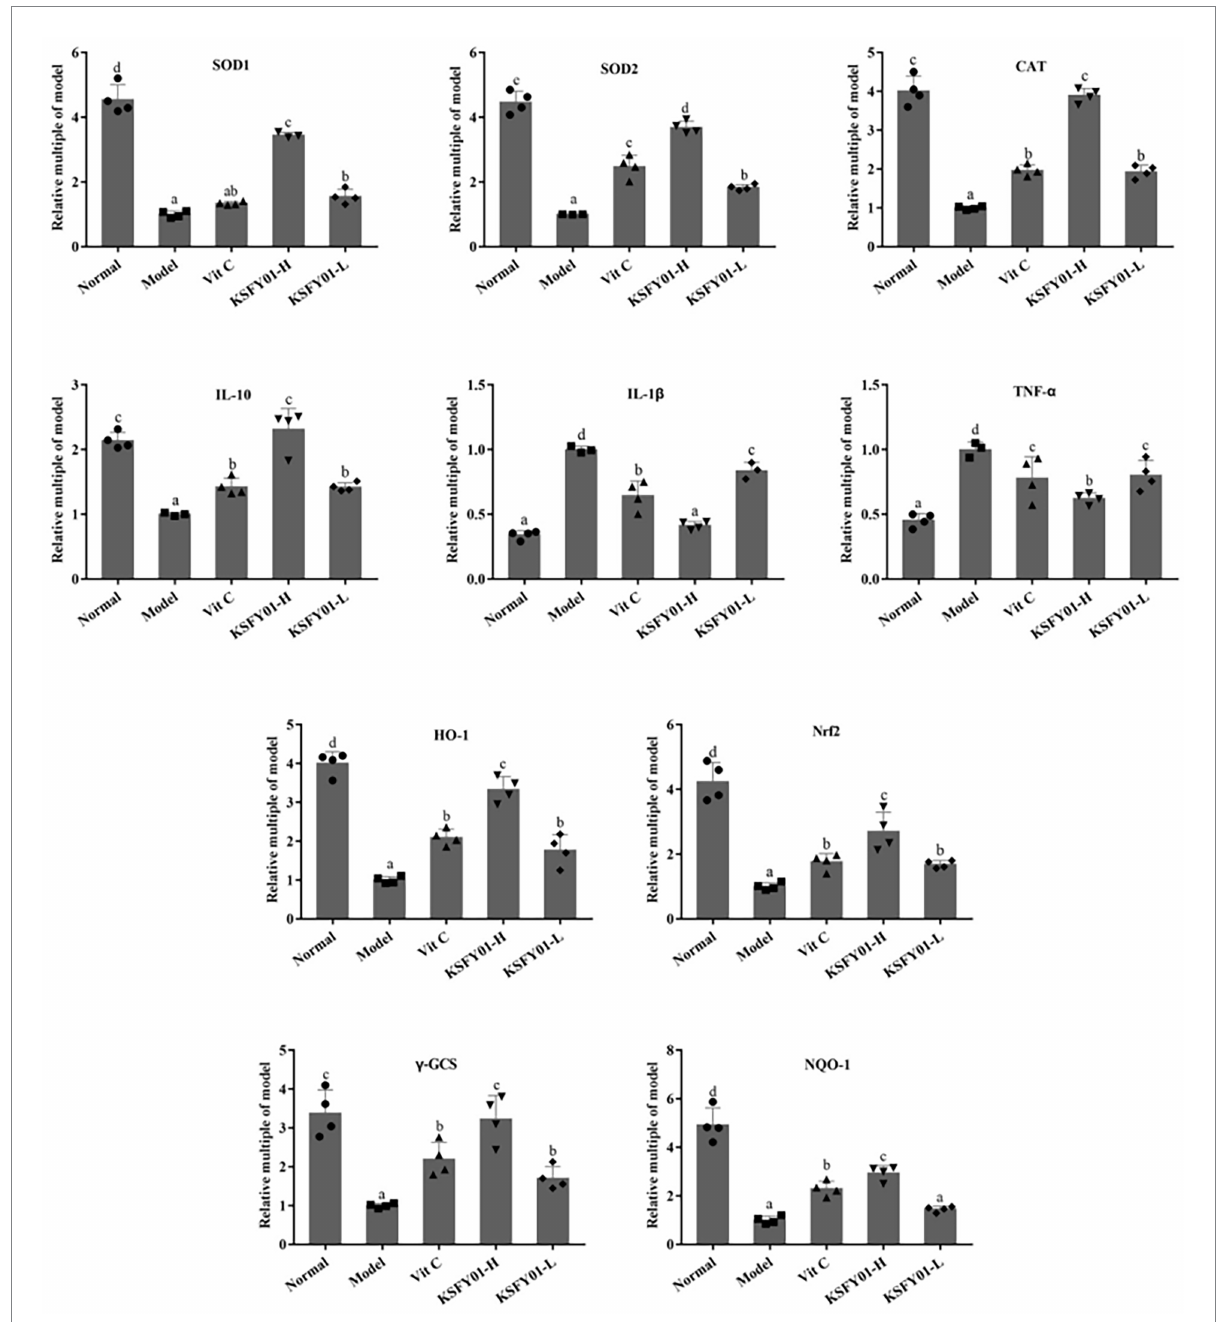
FIGURE 5 The SOD1, SOD2, CAT, IL-1 β , IL-10, TNF- α , HO-1, Nrf2, γ -GCS, and NQO-1 mRNA expressions in mouse liver tissue. a–e Values in the same column with different letter superscripts indicate significant difference ( p < 0.05). Vit C, mice treated with vitamin C (200 mg/kg); KSFY01-H, mice treated with L. plantarum KSFY01 (1 × 10 10 CFU/kg); KSFY01-L, mice treated with L. plantarum KSFY01 (1 × 10 9